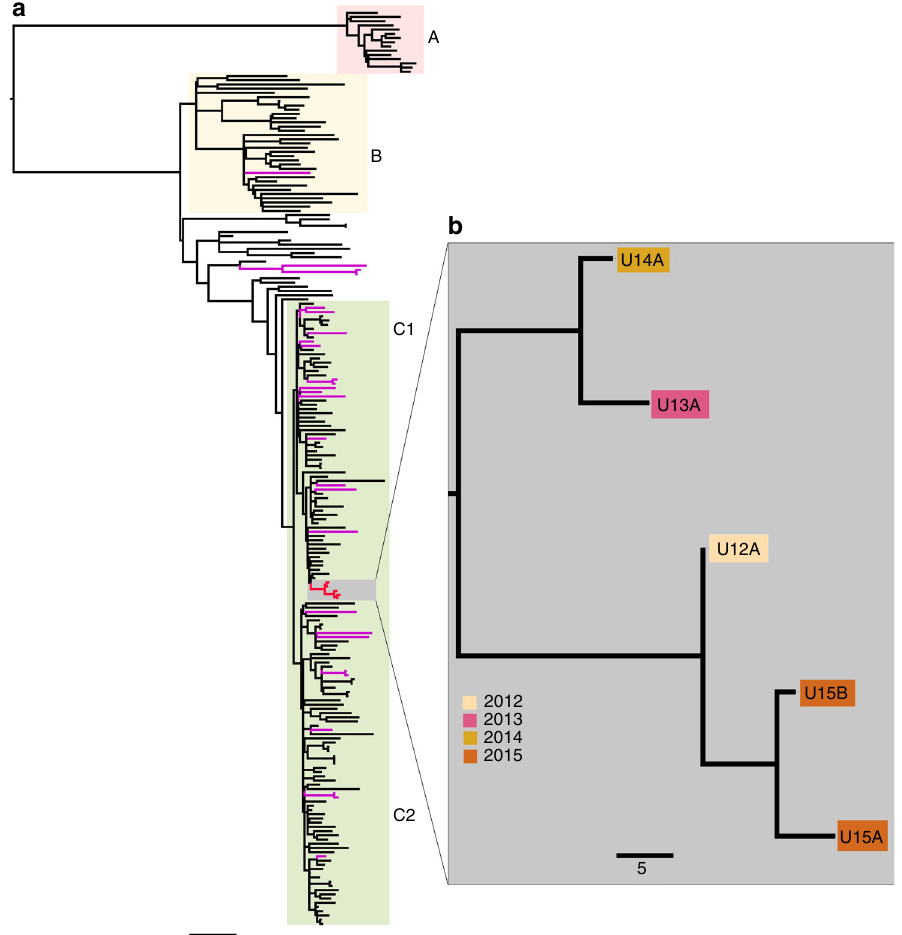
Fig. 1 Global representation of the ST131 phylogeny. a Maximum-likelihood phylogenetic tree built using 4286 single-nucleotide polymorphisms (SNPs) relative to E. coli EC958. Patient #1 isolates are highlighted in red and the additional Utah ST131 isolates in purple. The major ST131 phylogenetic clades are indicated: A = red, B = yellow, C1 and C2 = green. b Zoom-in depicting a maximum-likelihood phylogenetic tree of the 5 Patient #1 ST131 isolates constructed using 26 non-recombinant core genome SNPs. Isolates are coloured based on their data of isolation as indicated in the legend. The scale bar indicates branch length in number of SNPs. Phylogenetic trees were visualised using Figtree (http://tree.bio.ed.ac.uk/software/ fi